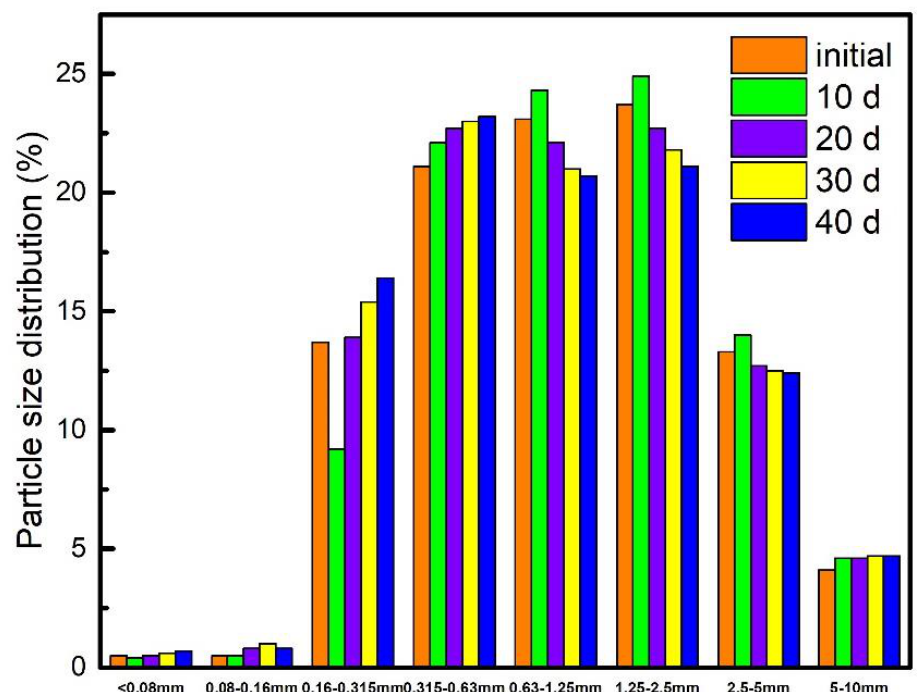
Figure 5. Change in particle size distribution of transition layer filler during operation.